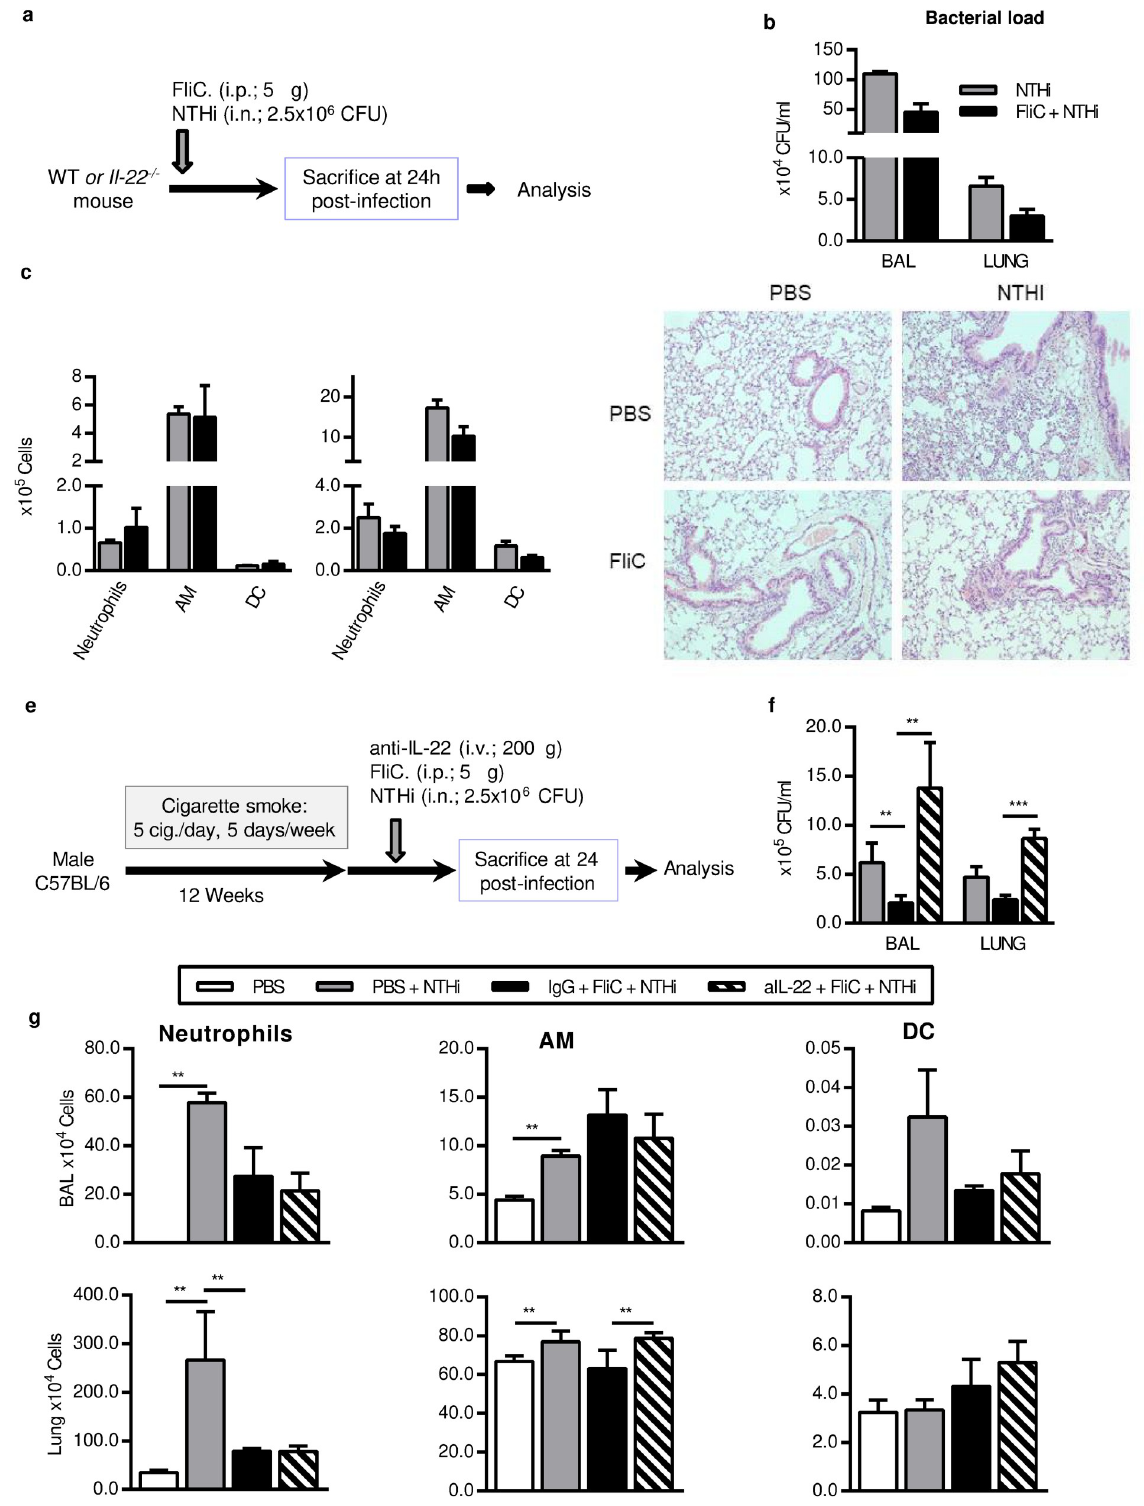
Fig 4. IL-22 is important in flagellin-mediated protection during NTHi infection. (a-d) Infection in Il22 -/- mice, (e-g) treatment of COPD mice with anti-IL-22 antibody. (a) To identify the role of IL-22 in the effect of flagellin during NTHi infection, Il22 -/- mice were challenged with NTHi at 2.5x10 6 CFU for 24h. (b) Bacterial load was assessed in BAL and lungs. (c) Absolute number of neutrophils, alveolar